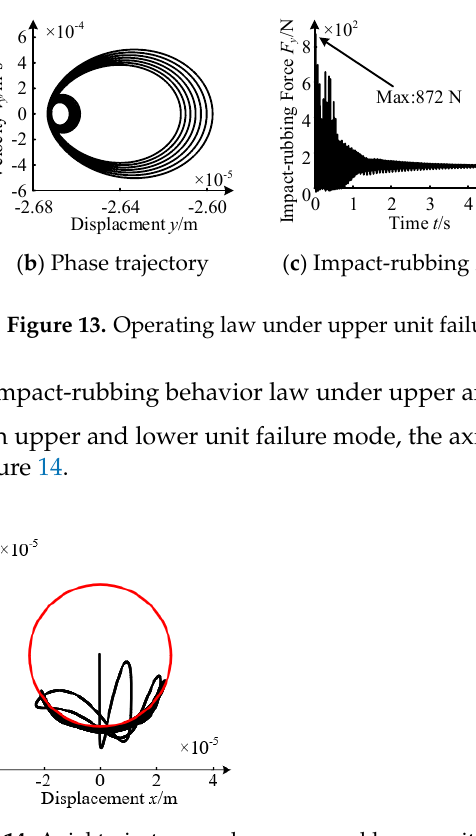
Figure 14. Axial trajectory under upper and lower unit failure.